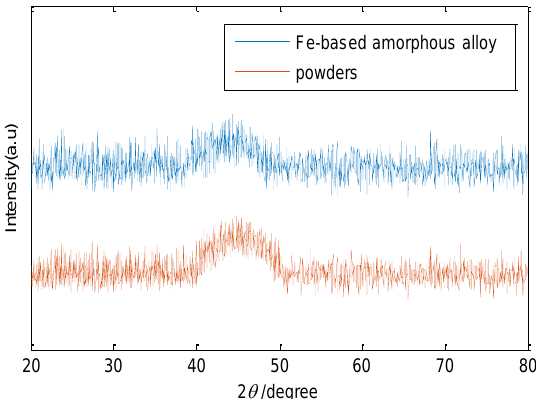
Figure 4. X-ray diffraction (XRD) patterns of the original powder and explosively compacted